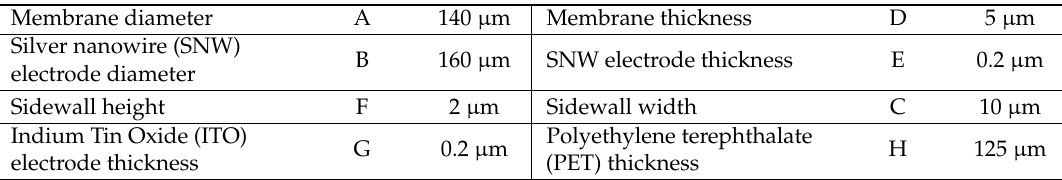
Figure 3. Cross-sectional view of a transparent CMUT. Table 1. Transparent CMUT dimensions.